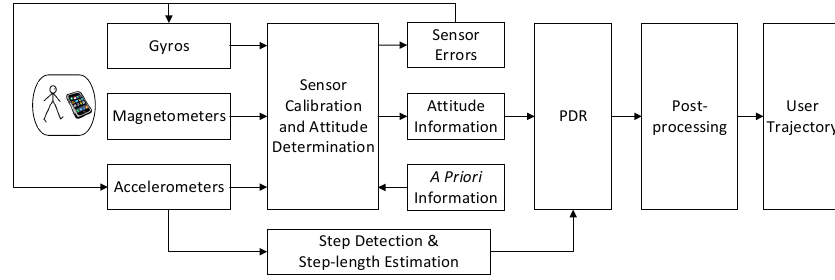
Figure 1. Main components of sensor-based navigation